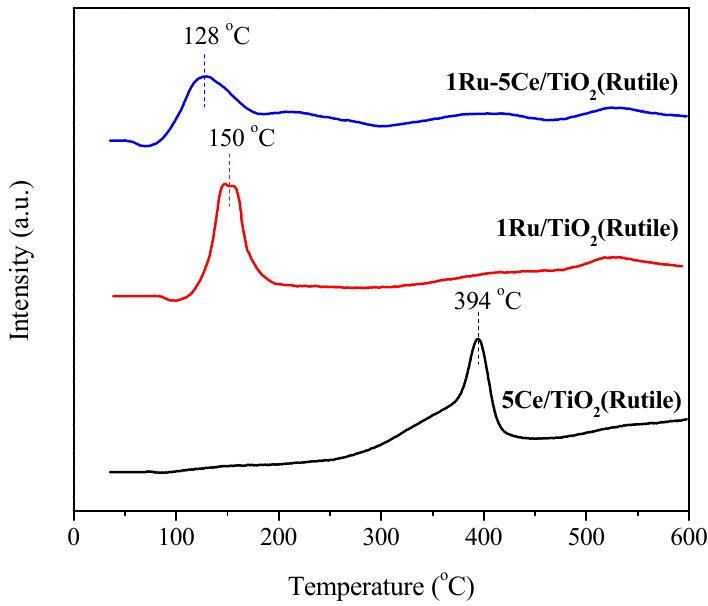
Figure 10. H 2 ‐ TPR profiles of 1Ru ‐ 5Ce/TiO 2 (Rutile), 1Ru/TiO 2 (Rutile), and 5Ce/TiO 2 (Rutile). Figure 10. H 2 -TPR profiles of 1Ru-5Ce/TiO 2 (Rutile), 1Ru/TiO 2 (Rutile), and 5Ce/TiO 2